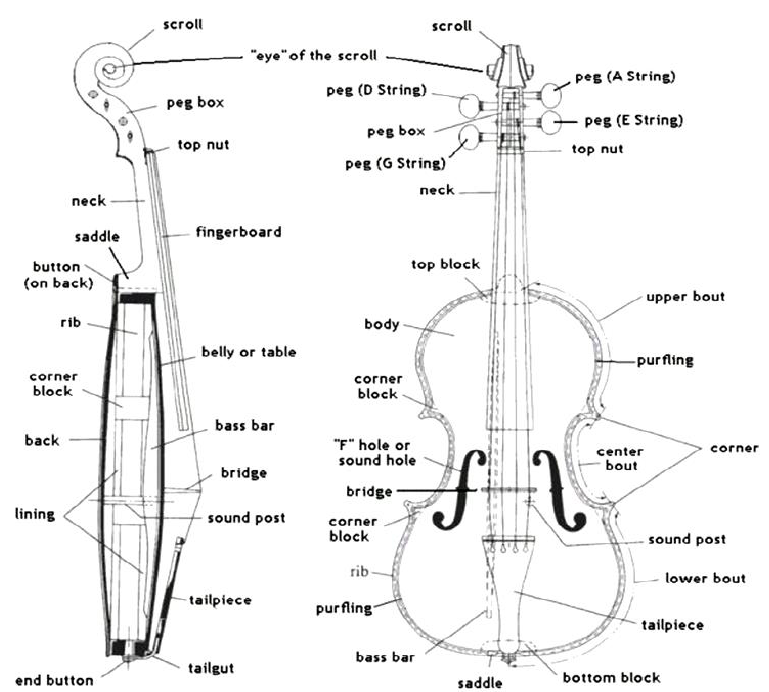
Figure 2. The functional and structural components used in evaluation of violin type/model [21].